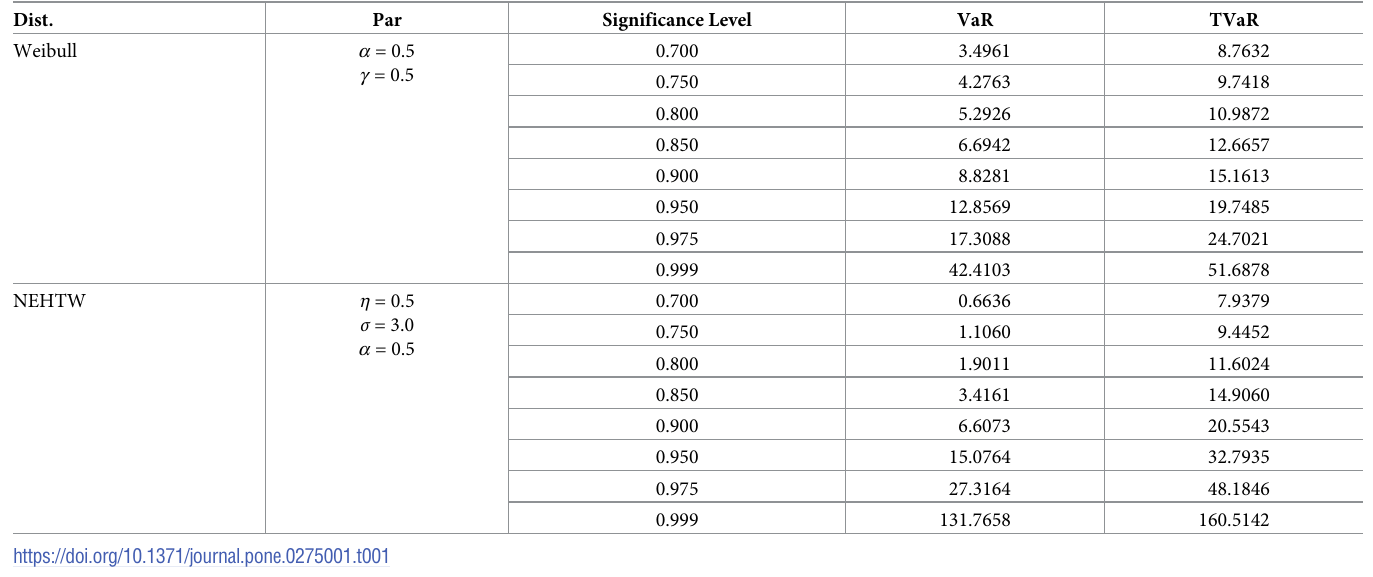
Table 1. Simulated values of the VaR and TVaR at different significance levels for n = 100. Dist.